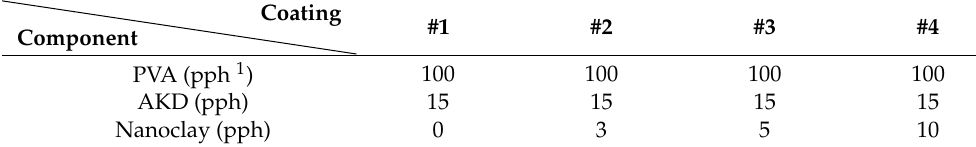
Table 2. Coating